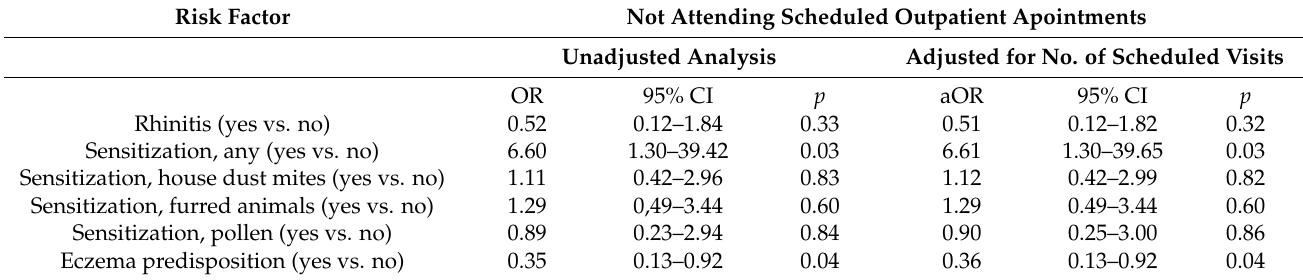
Table 3. Multivariate risk factor analysis of not attending scheduled asthma outpatient appointments.